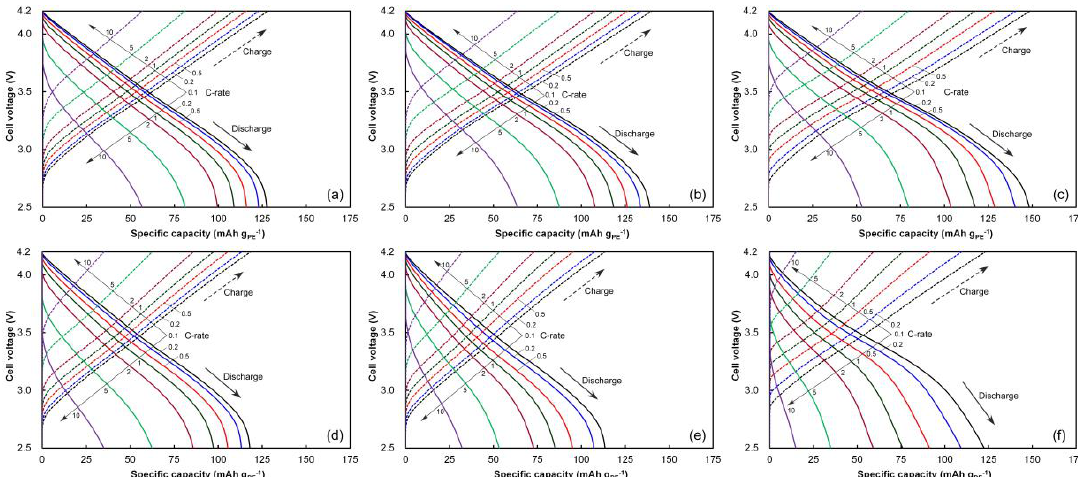
Figure 7. Rate behavior of the full-cells before and after charge-discharge cycling: ( a ) pristine HC cell before cycling; ( b ) shallow prelithiation HC cell before cycling; ( c ) cycling prelithiation HC cell before cycling; ( d ) pristine HC cell after cycling; ( e ) shallow prelithiation HC cell after cycling; ( f ) cycling prelithiation HC cell after cycling. The C-rates varied from 0.1 to 10 C-rate, and the cut-off cell voltage range was 2.5–4.2 V; 1 C-rate is 170 mA g PE−1 . Results of the third cycle for each C-rate test are shown.